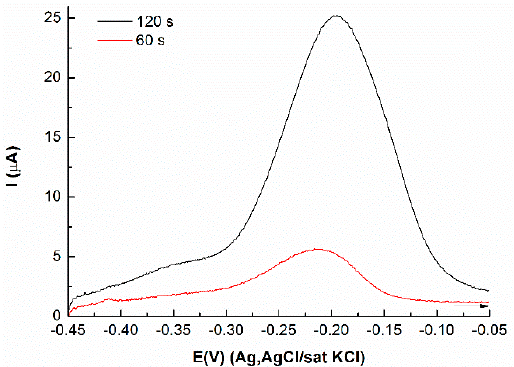
Figure 7. Anodic stripping curves of Mo deposited at E = − 0.85 V on Se ad /Ag(111) in ammonia buffer pH 9.2 after a − 0.45 V washing step. The scan rate is 10 mV·s − 1 . The curves refer to deposition times from 1 and 2 min.